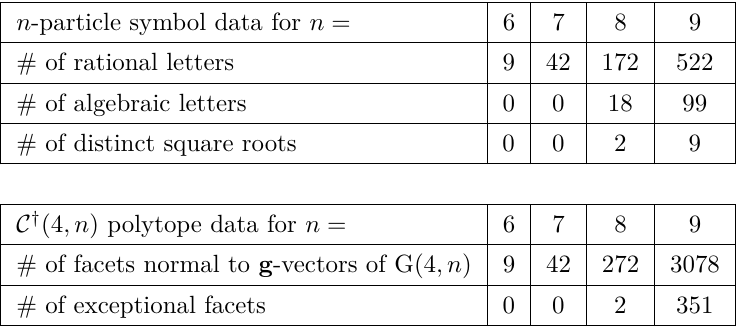
Table 2. Summary of data about known symbol letters of n -particle amplitudes in SYM theory. On the top line we omit the n frozen variables of G(4 , n )